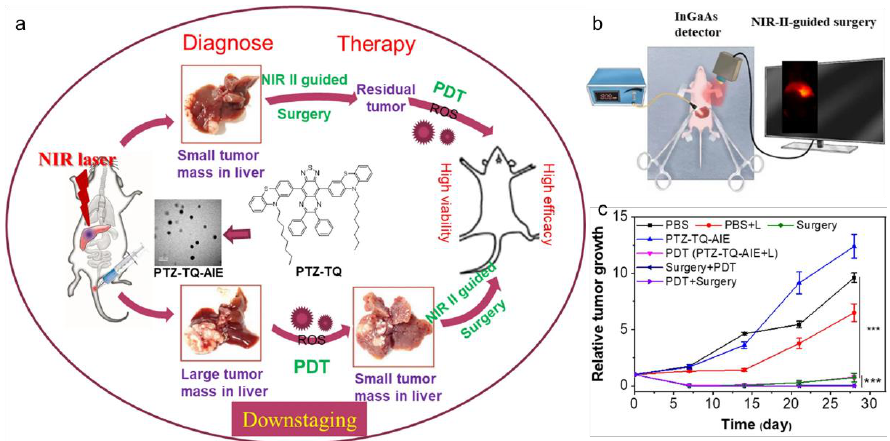
Figure 7. ( a ) Schematic illustration of the NIR-II PTZ-TQ for sensitive imaging-guided surgery and phototherapy of orthotopic hepatic tumors. ( b ) Schematic illustration of PTZ-TQ NPs for NIR-II fluorescence imaging-guided tumor resection. ( c ) Relative tumor growth curves of orthotopic liver tumor-bearing mice with different treatments ( n = 3) (Reprinted with permission from Ref. [103]. Copyright 2021, Springer Nature).